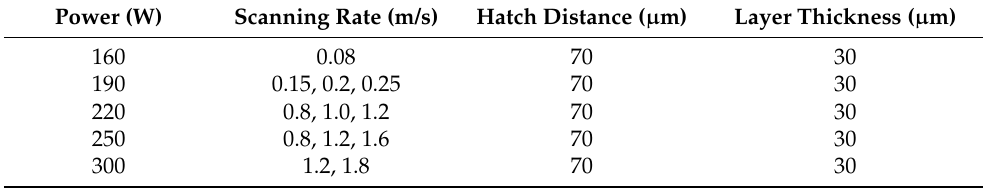
Table 1. Processing parameters used in the sample printing experiment.